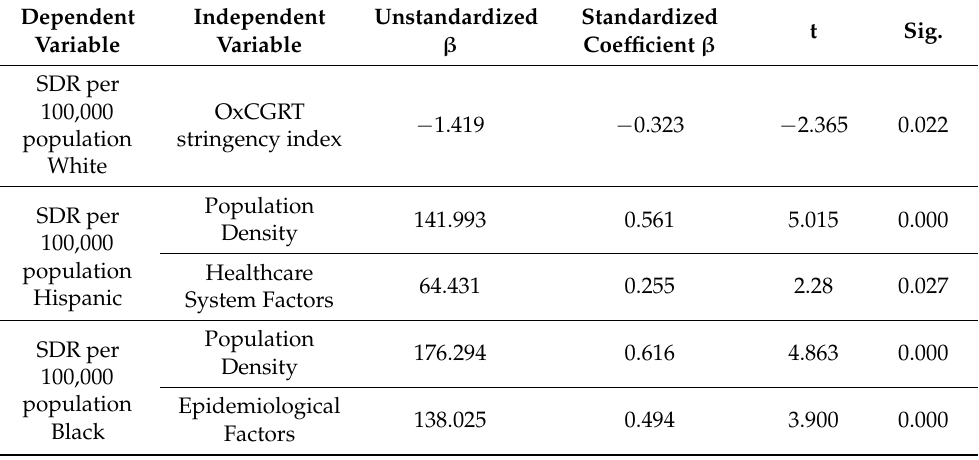
Table 4. Coefficients between each independent variable and SDR for White, Hispanic, and Black